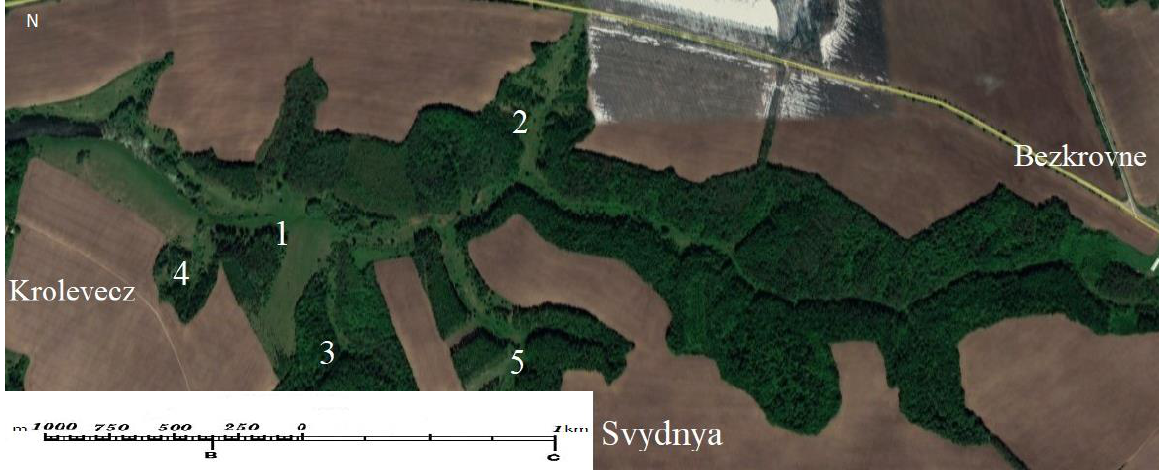
Fig. 1. Growth of C. ucrainica in the studied areas (№ 1‒5) in the beam system in the valley of the River Svydnya between the villages of Bezkrovne, Svydnya and Krolevecz (Sumy region) (space